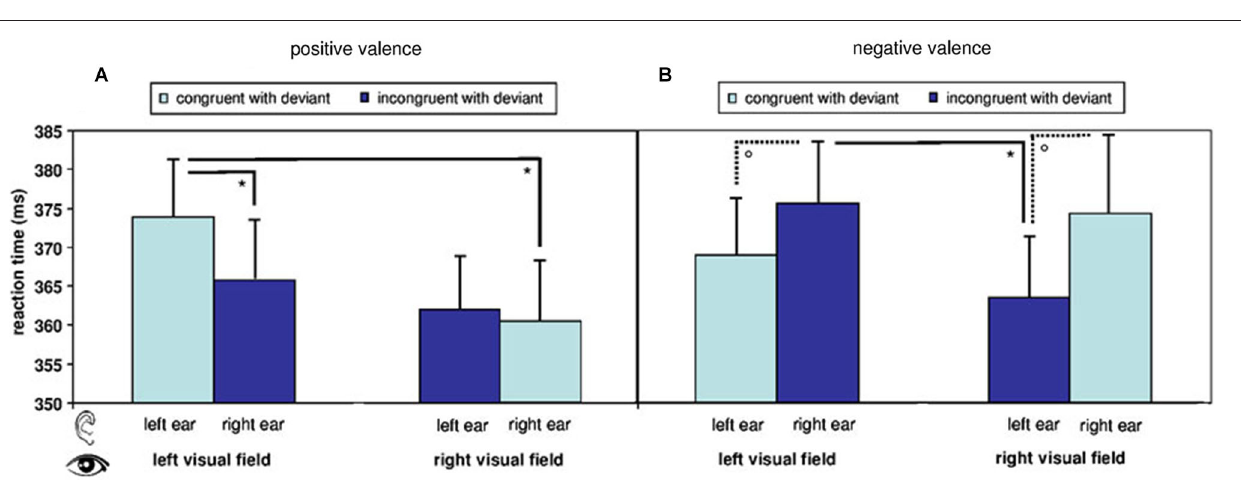
FIGURE 2 | Reaction times in response to visual target stimuli during fMRI . Reaction times are modulated by a main effect of stimulus valence and by an interaction of valence, visual field of presentation, and spatial congruency of visual with auditory deviant. Overall reaction time pattern reflects a difference in processing of positive and negative stimuli with regard